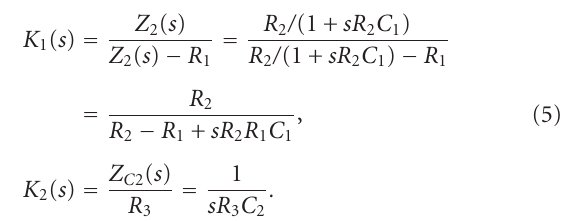
driving elements with equal parameters in enhanced OS shown in Figure